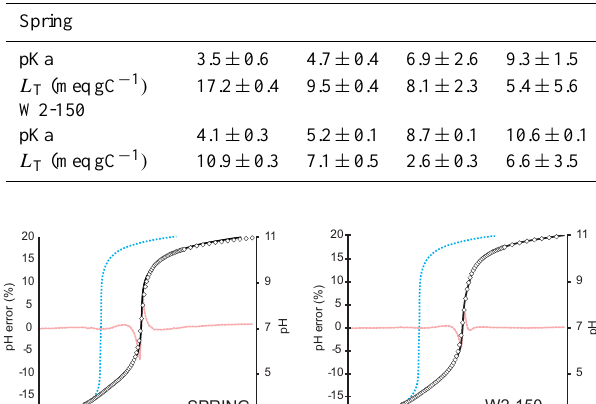
Table 4. Result of modeling the microtitration curves by 4 discrete acidic sites – pKa and site density L T .